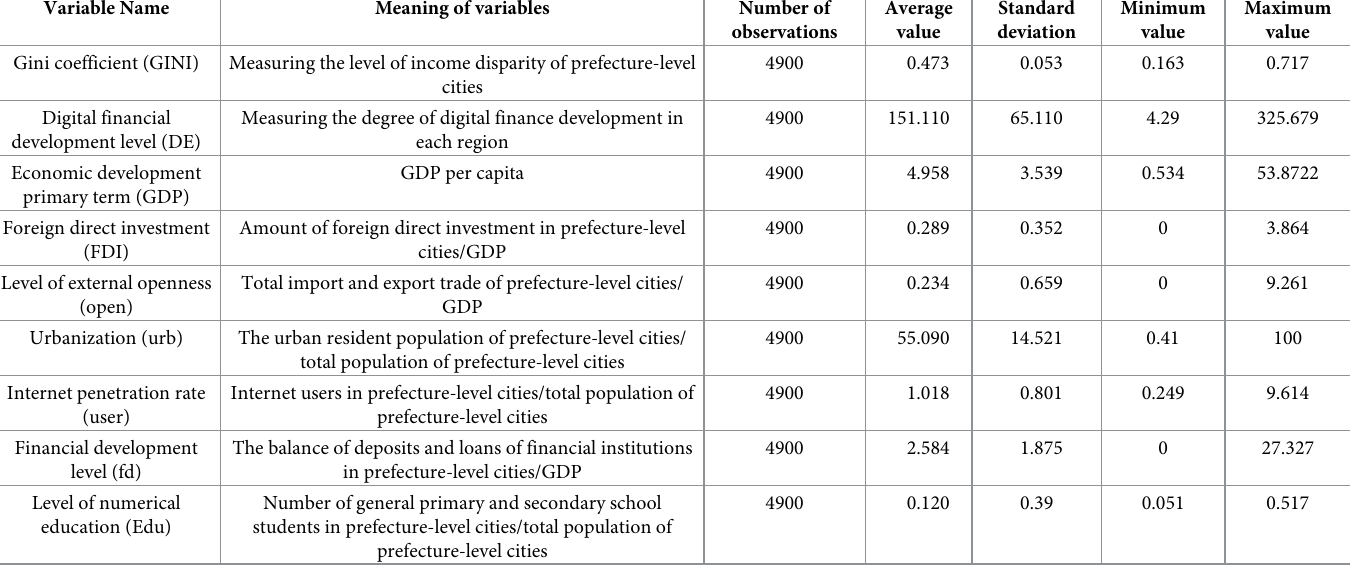
Table 1. Descriptive statistics of the main